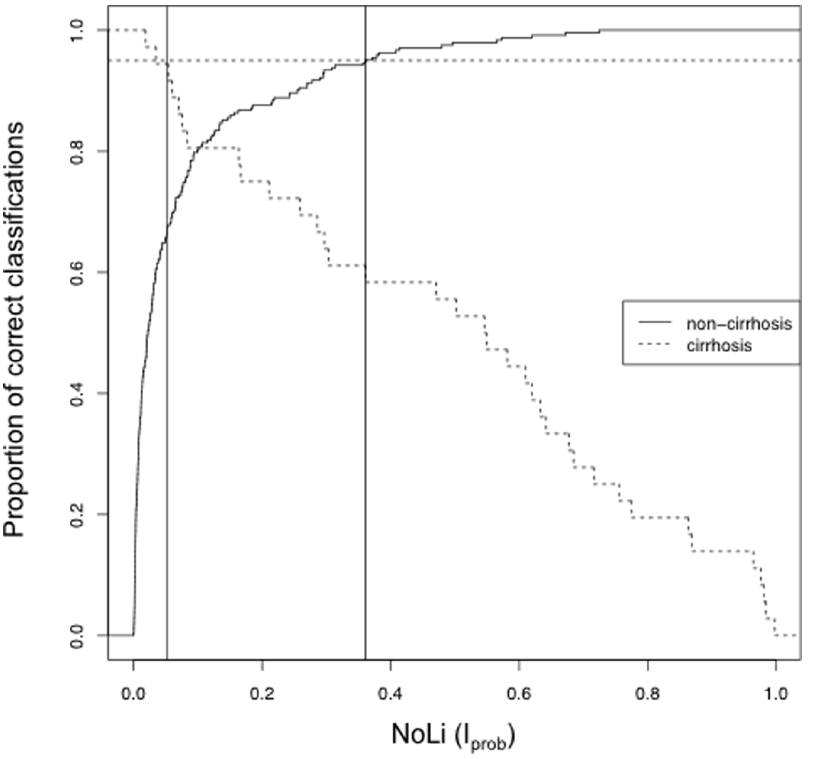
Figure 3. Proportion of correct classifications (i.e. non-cirrhotic classified as non-cirrhotic and cirrhotic classified as cirrhotic) according to different cut-off levels for NoLI. The solid vertical lines represent the chosen cut-offs 0.054 and 0.37. Using these cut-offs, the misclassification error would be approximately 5% for cirrhotic as well as non-cirrhotic patients, respectively (dotted horizontal line).